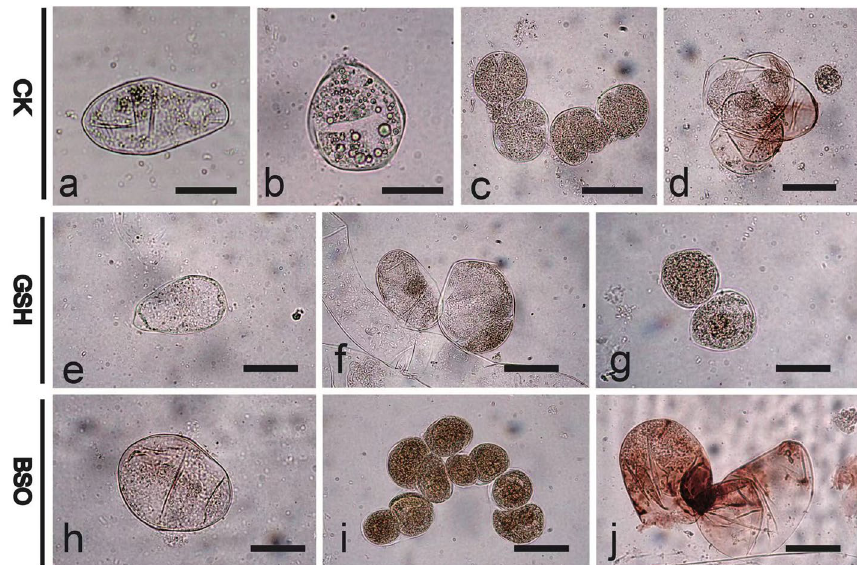
Figure 5. Effects of exogenous GSH and BSO on in situ H 2 O 2 production in EC cells of Korean pine. ( a , e , i ) F-CK proliferation on day 0; ( b ) F-CK proliferation on day 7; ( c ) F-CK proliferation on day 21; ( d ) F-CK proliferation on day 35; ( f ) F-GSH proliferation on day 7; ( g ) F-GSH proliferation on day 21; ( h ) F-GSH proliferation on day 35; ( j ) F-BSO proliferation on day 7; ( k ) F-BSO proliferation on day 21; ( l ) F-BSO proliferation on day 35. Bars = 30